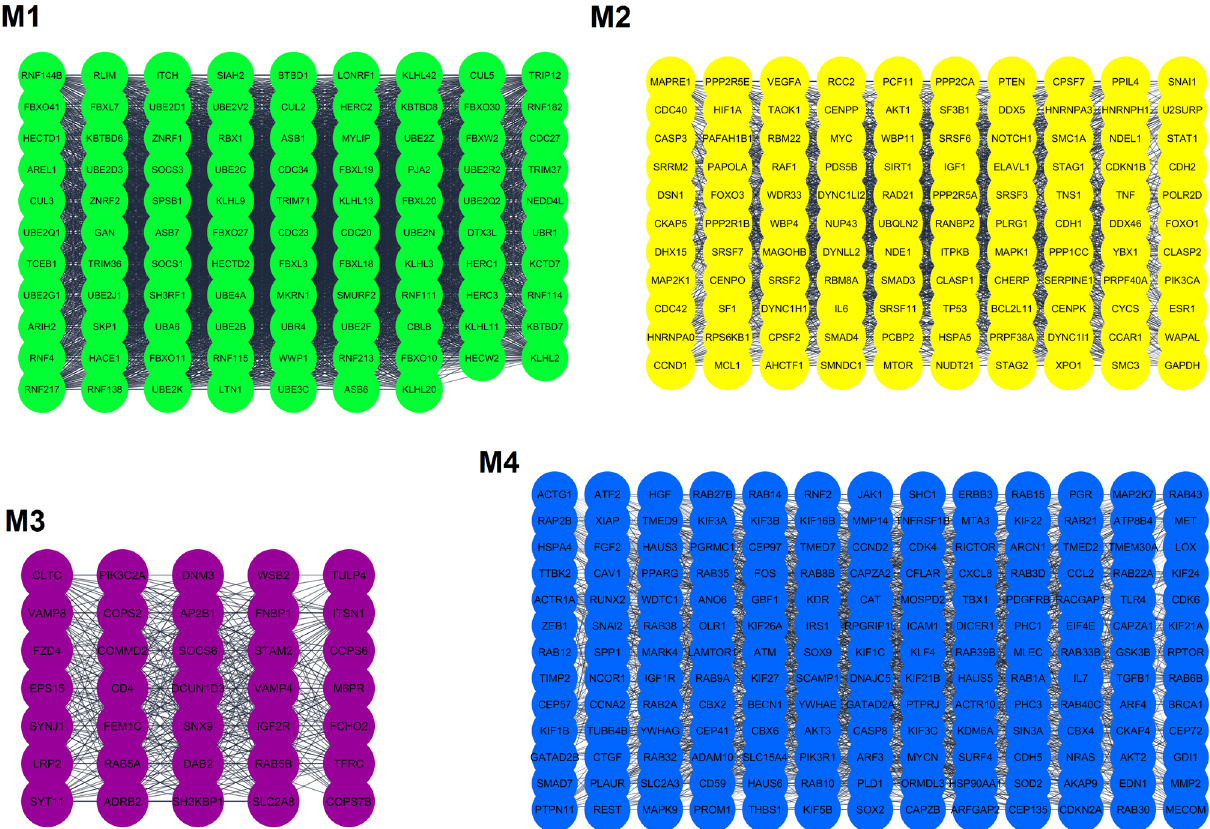
Figure 3. The PPI network (top four modules) of genes potentially targeted by enoxacin-induced miRNAs. The PPI network of genes predicted to be targeted by enoxacin-induced miRNAs were depicted by Cytoscape (only interactions with the confidence of a combined score > 0.400 were included) and protein modules were identified by MCODE (cutoff criteria were ‘degree cutoff = 2’, ‘k-core = 2’, ‘node score cutoff = 0.2’, and ‘maximum depth = 100). M: Module.